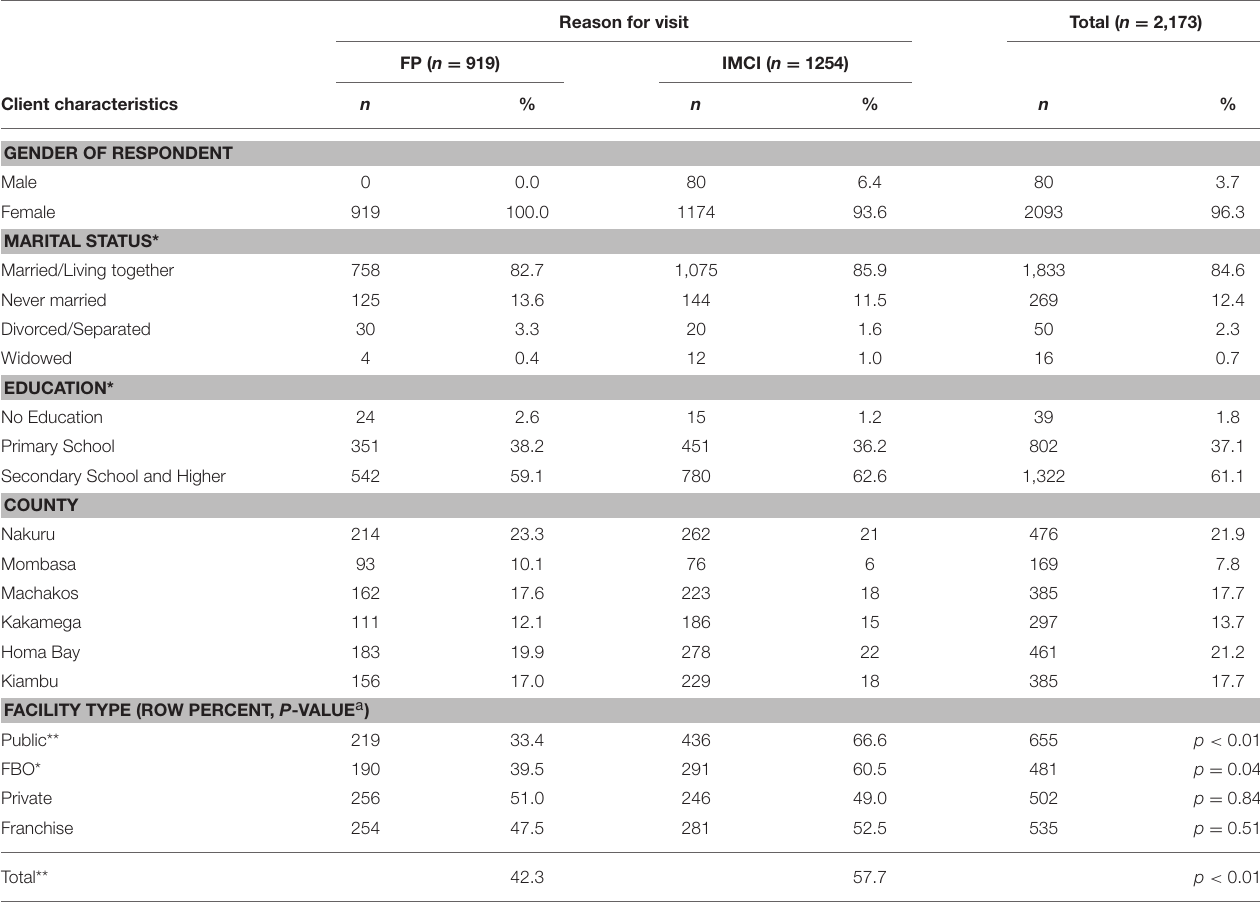
TABLE 2 | Client Characteristics by reason for visit.